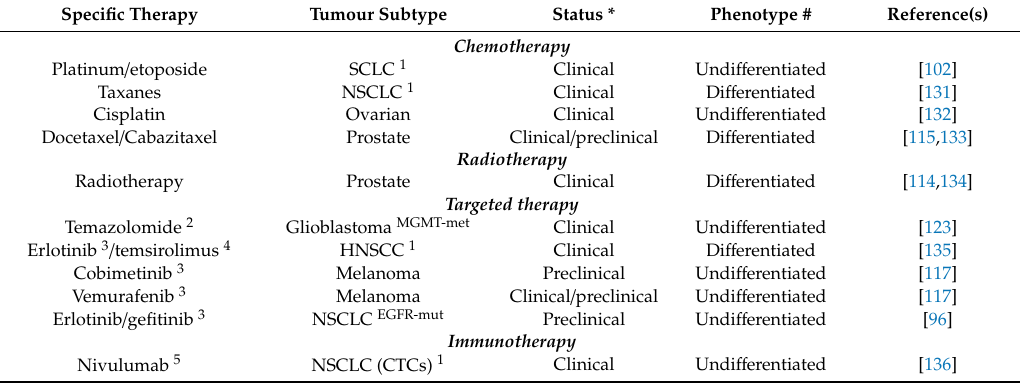
Table 2. Examples of the contribution of epithelial plasticity to treatment resistance in cancer